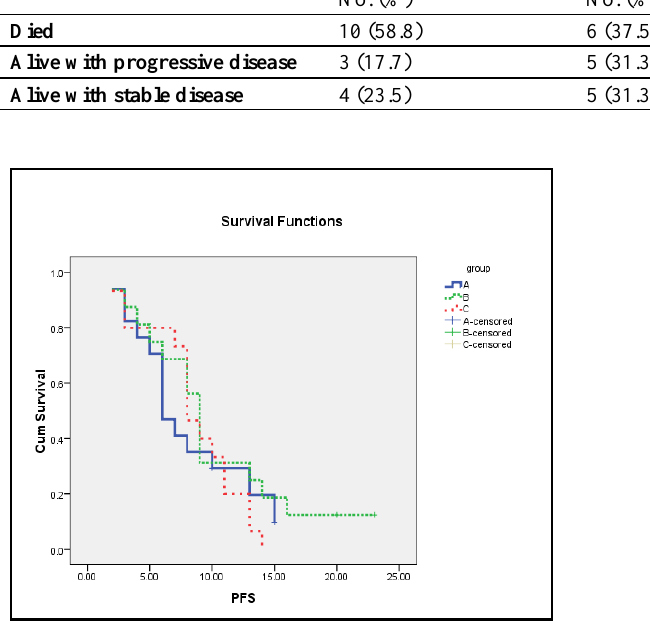
Figure 1: Progression-free survival (PFS) in months by treatment group (group A: conventional RT, group B: Hypofractionated RT & group C: Hyperfractionated)